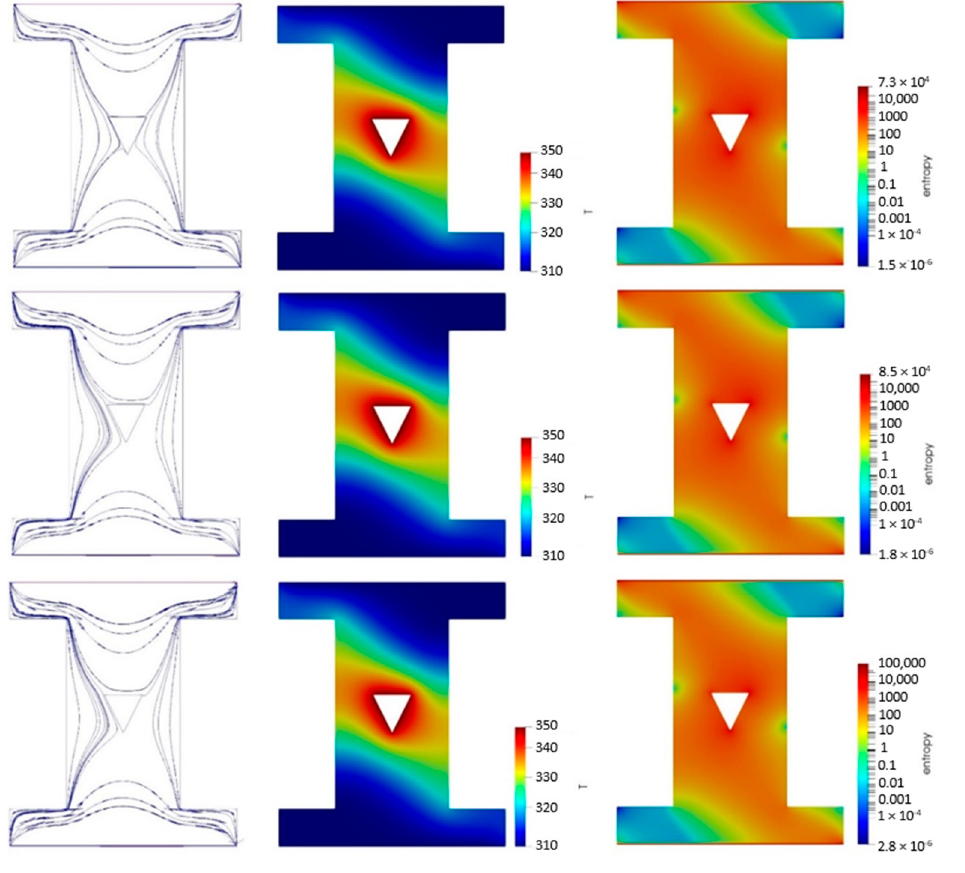
Figure 9. The streamlines ( left ), temperature ( middle ) and entropy generation ( right ) contours of the NF in the metallic powder-based porous cavity for the down-oriented hot block and the NP volume concentrations of 0% ( the first row ), 2% ( the middle row ) and 4% ( the bottom row ).